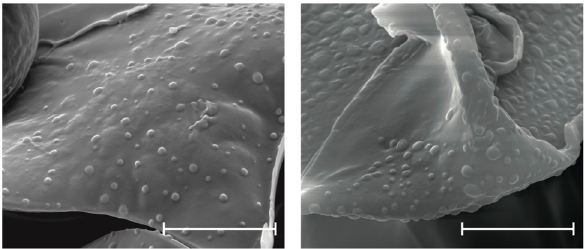
Figure 1. Representative SEM images of (TC 20 CR 0.5) pNPs after the complex coacervation method. Scale bars represent 4 μ m.